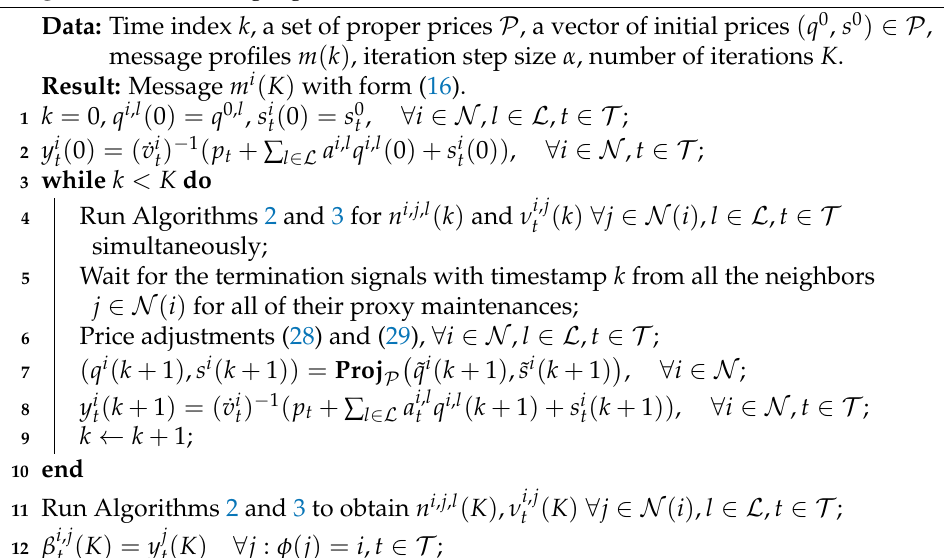
Algorithm 4: Learning algorithm for user i in the distributed